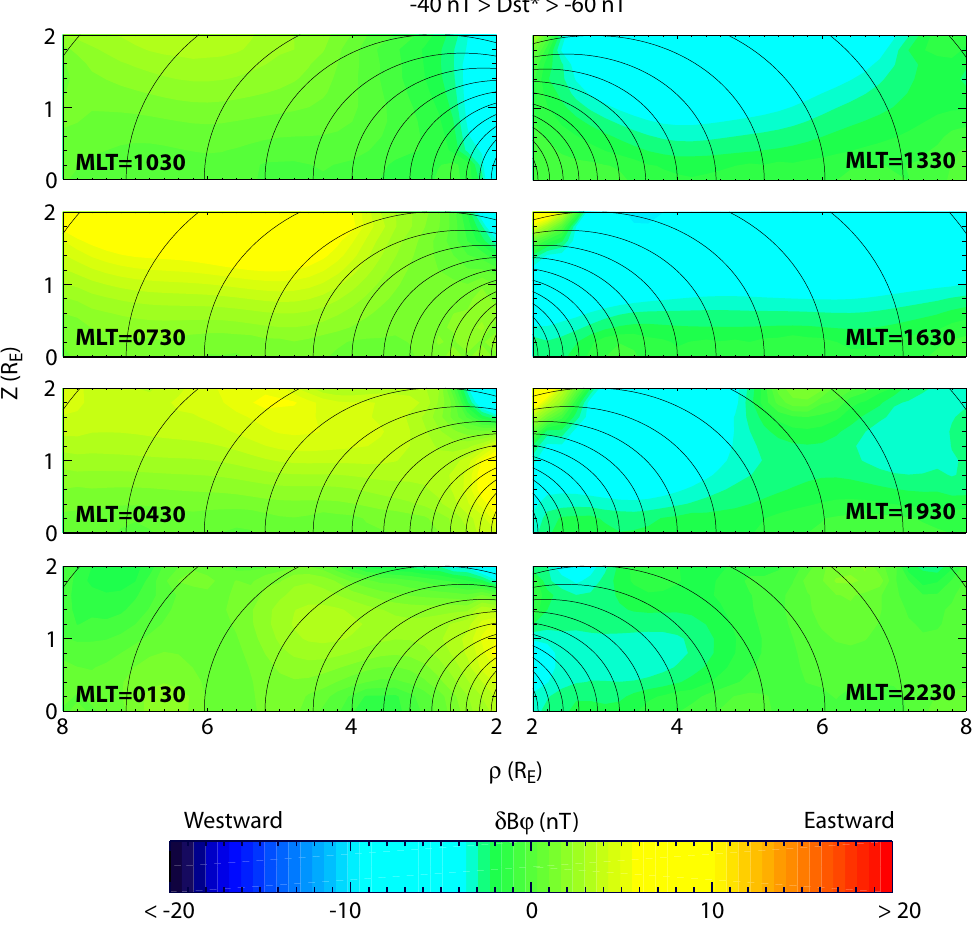
Fig. 5b. Azimuthal component of perturbation magnetic field with superimposed dipole field lines in each of the 8 magnetic local time bins and for each of the four D st * ranges. Only the northern meridian plane is shown. The southern part is anti-symmetric to the northern part: (b) − 40nT >D st * > −